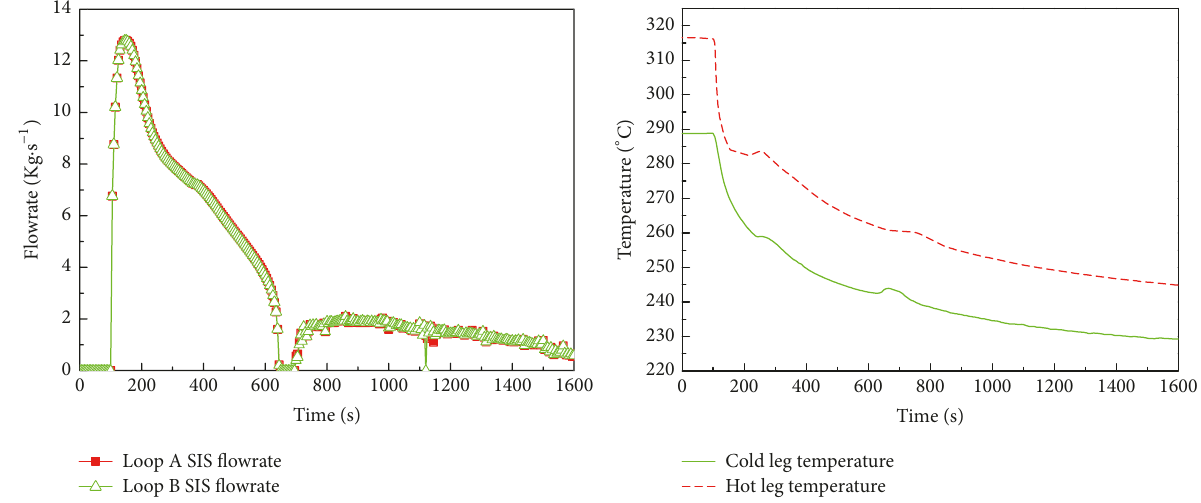
Figure 4: Variations of SIS flow rate and coolant temperature versus time.